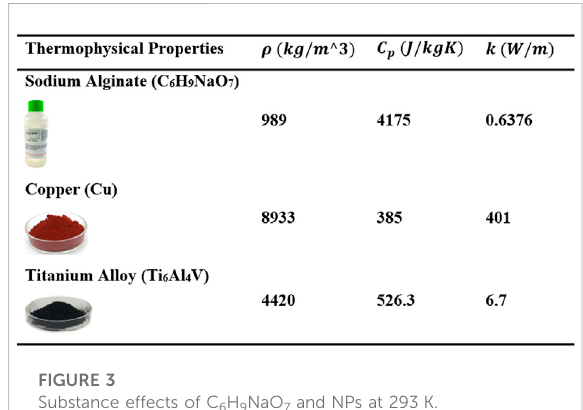
FIGURE 3 Substance effects of C 6 H 9 NaO 7 and NPs at 293